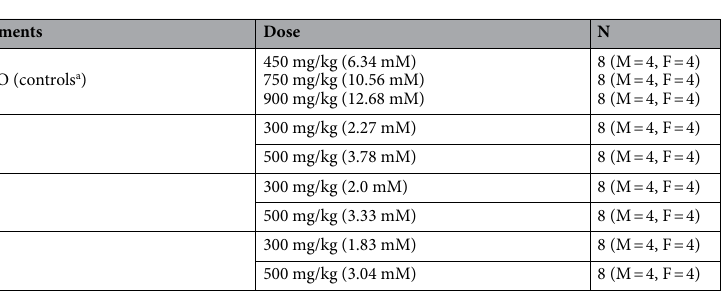
Figure 1. Animal treatment and observation schemes. Mice arrived on Day -2 and were sexed. The mice then had a 48 h acclimation time. On the morning of Day 0, the mice were weighed and injected. Mice were observed hourly for two h, and twice daily post-injection until Day 4 when mice were weighed and euthanized for dissection. Red and gray vertical bars indicate the times of observation and days of experimentation, respectively.